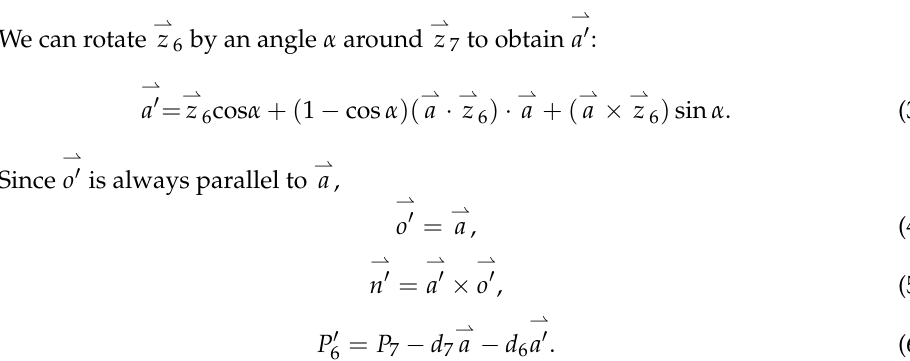
Figure 4. In order to study the influence of the redundancy angle on the tip pose of the 6-DOF subchain, we give the geometric relationship between the seventh and sixth